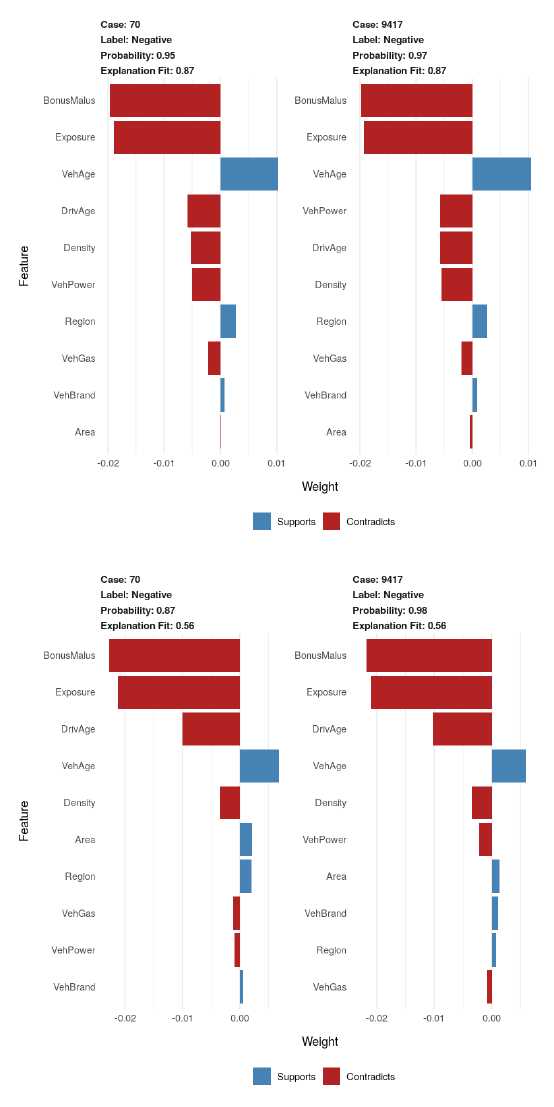
Figure 7. Feature importance for predicting a positive and negative example for logistic regression ( top ) and neural networks ( bottom